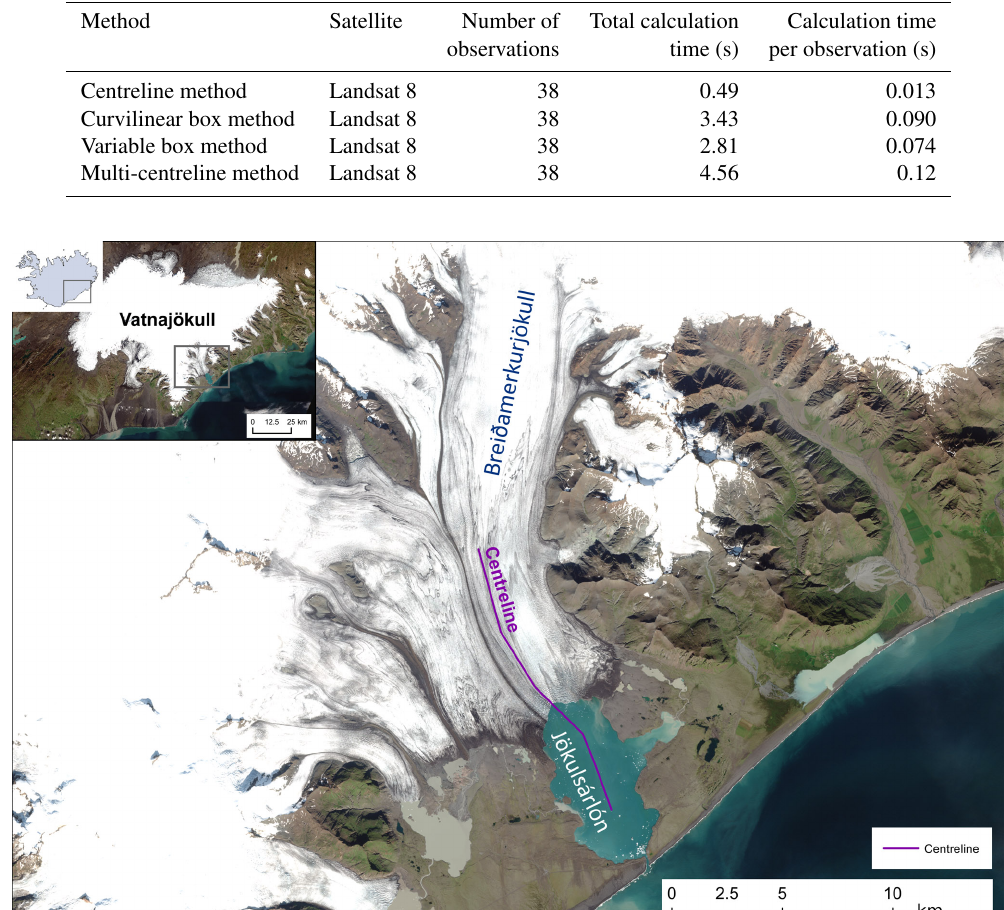
Figure 2. Location map and centreline of Breiðamerkurjökull, SE Iceland. Imagery shows a true-colour composite of four Sentinel 2A scenes acquired on 20 August